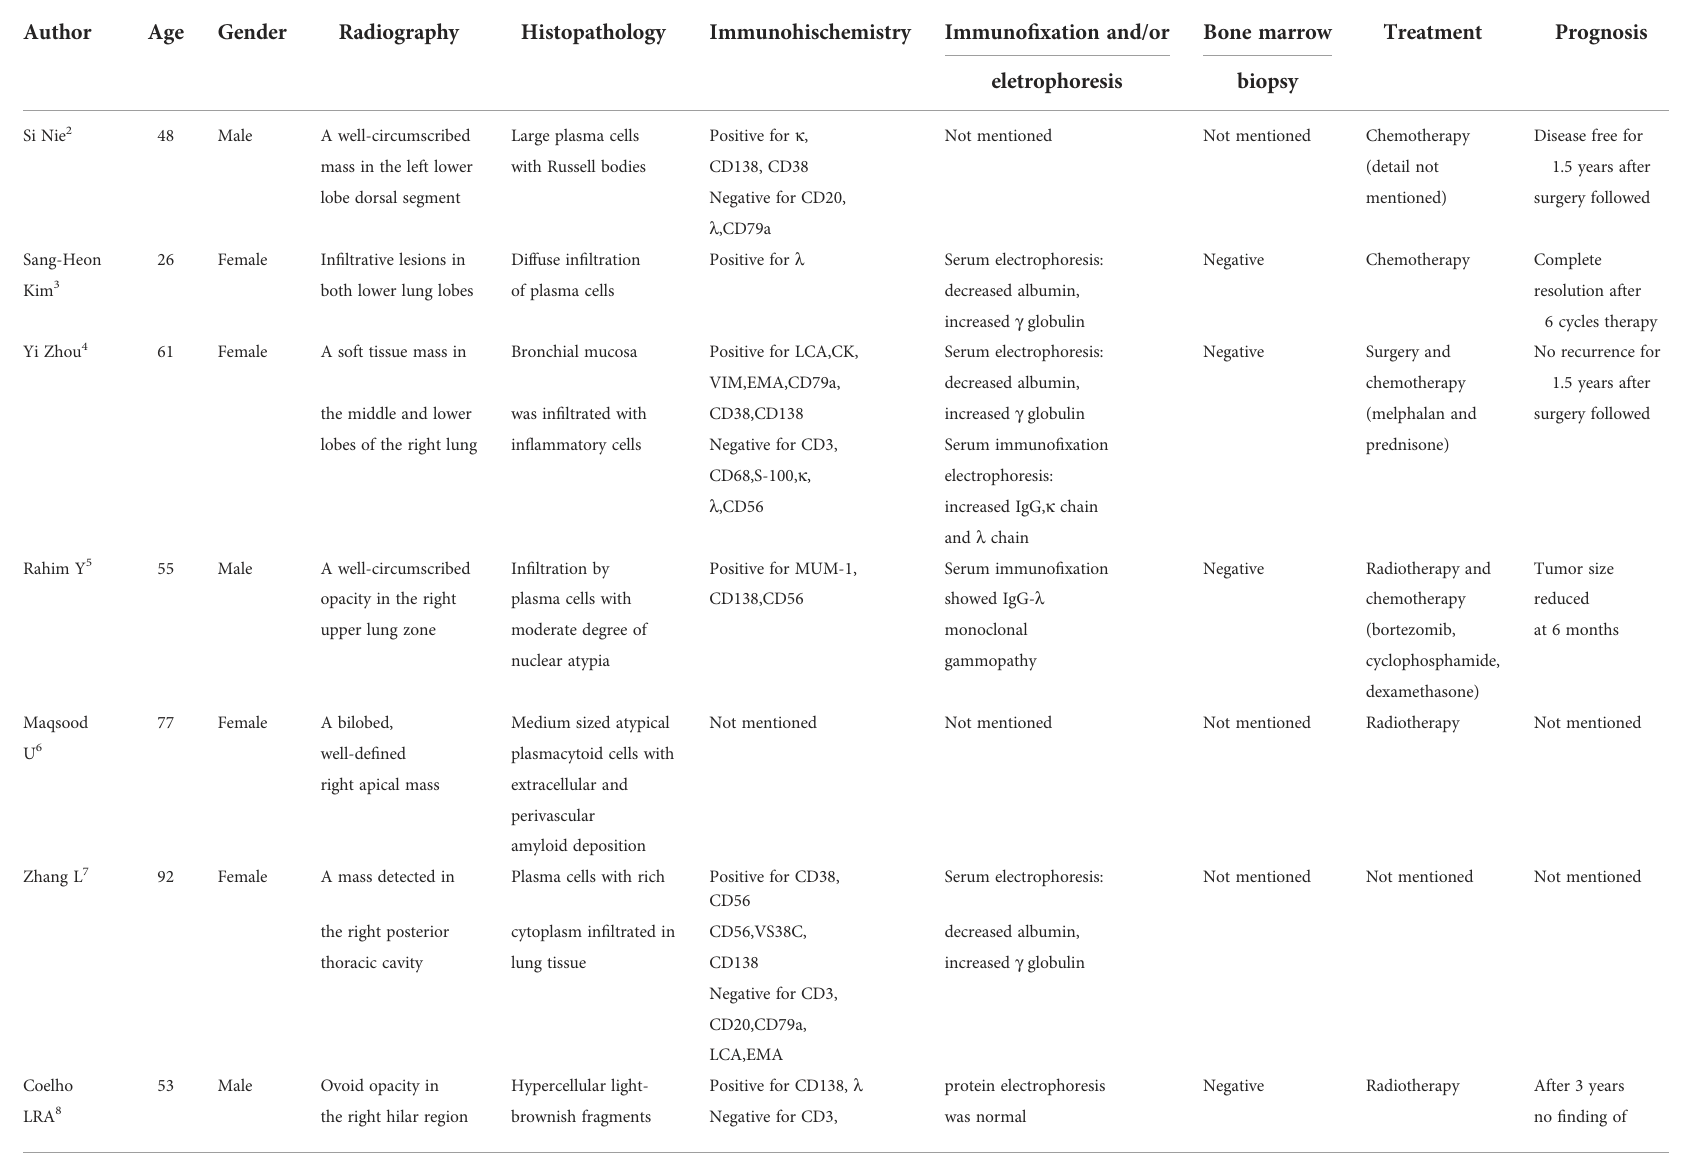
TABLE 1 Summary of the literature in the clinical treatment and prognosis of primary pulmonary